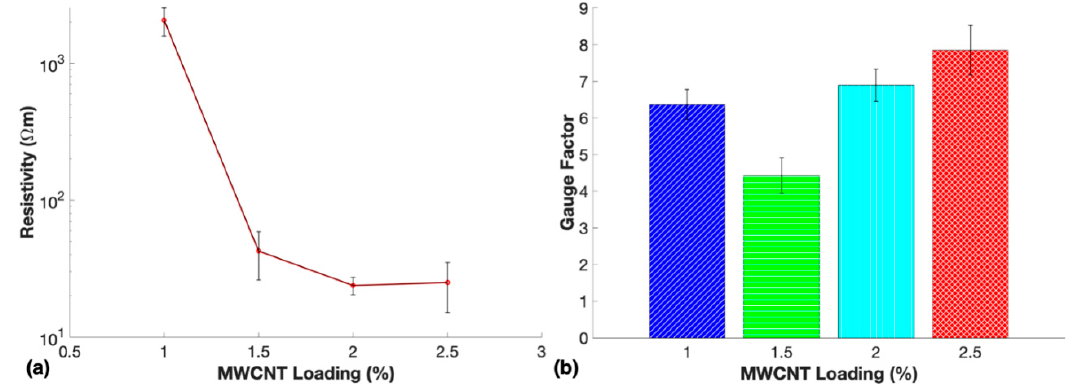
Figure 7. ( a ) Resistivity measurements and ( b ) average gauge factors at 10% compressive strain of porous nanocomposites containing 1.0 wt. %, 1.5 wt. %, 2.0 wt. %, and 2.5 wt. % MWCNTs.